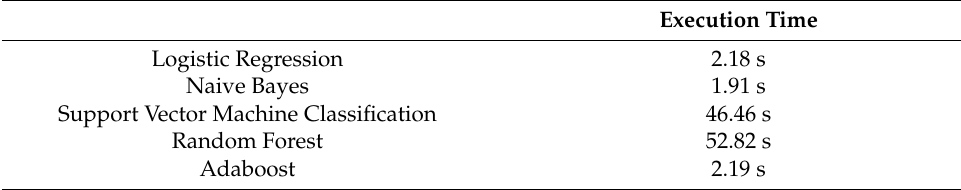
Table 7. Comparison of data processing